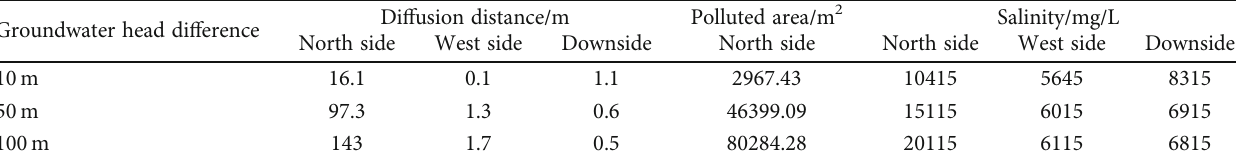
Table 5: Part of the simulation data under di ff erent groundwater head di ff erences during 30 years of long-term penetration. Groundwater head di ff